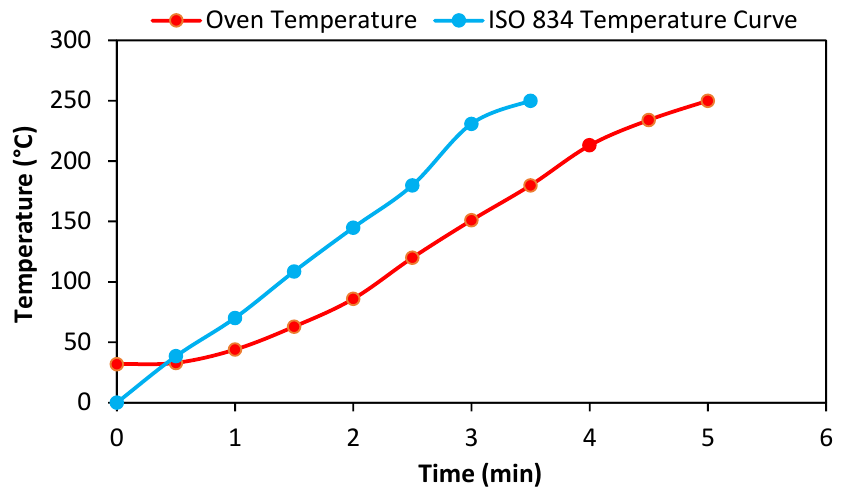
Figure 16. Comparison of the rise in an oven temperature and ISO 834 standard fire curve up to 250°C.